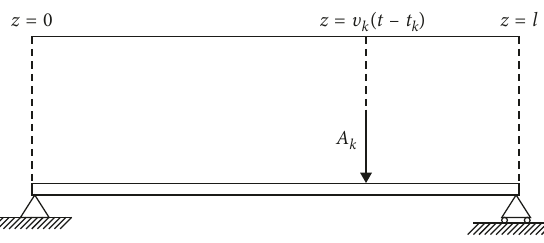
Figure 1: Schematic of the adopted